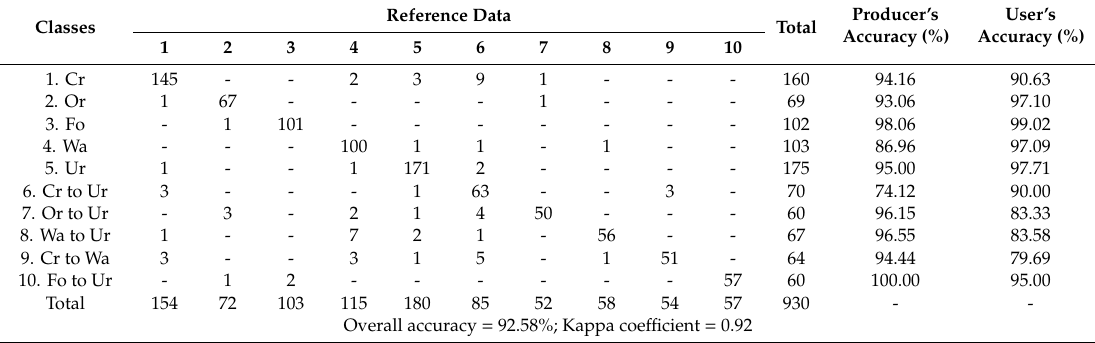
Table 5. Confusion matrix of the PCA-based method, 2003–2006.